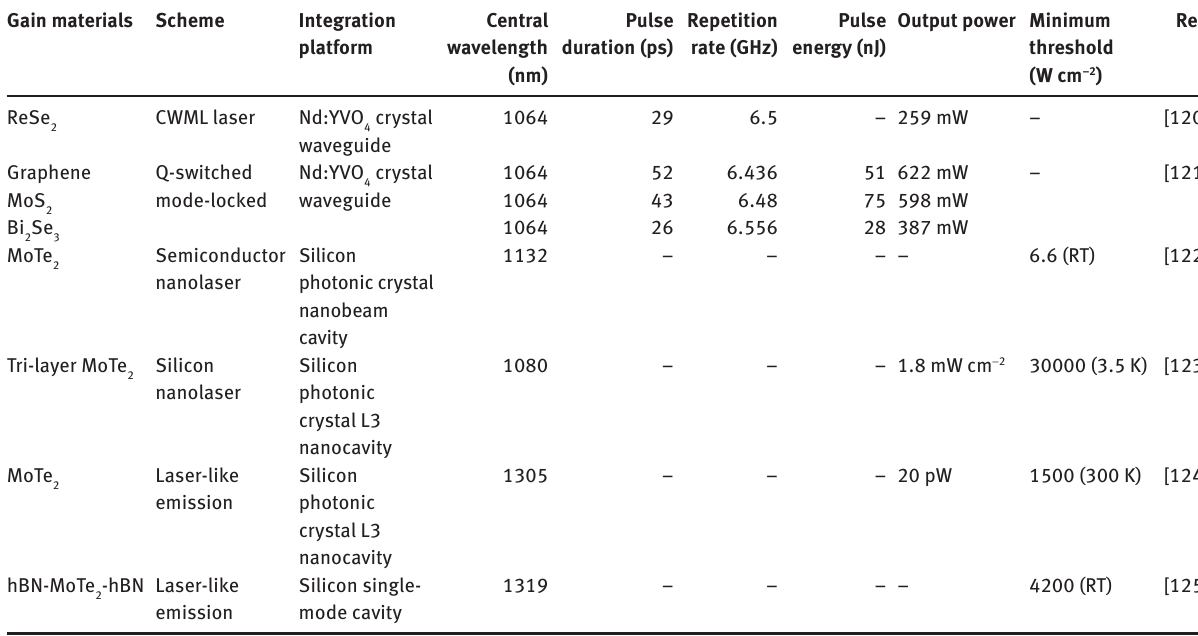
Table 3: Performance summary of waveguide laser based on 2D materials. Gain materials